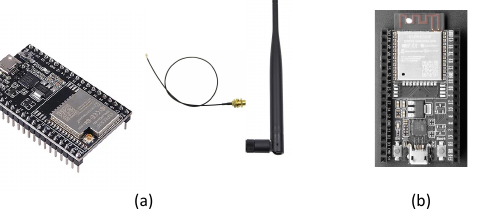
Figure 2. ( a ) ESP32-WROOM-32U and the 2.4 GHz 6 dBi omnidirectional antenna, and ( b ) ESP32- WROOM-32D development board with the onboard PCB antenna.